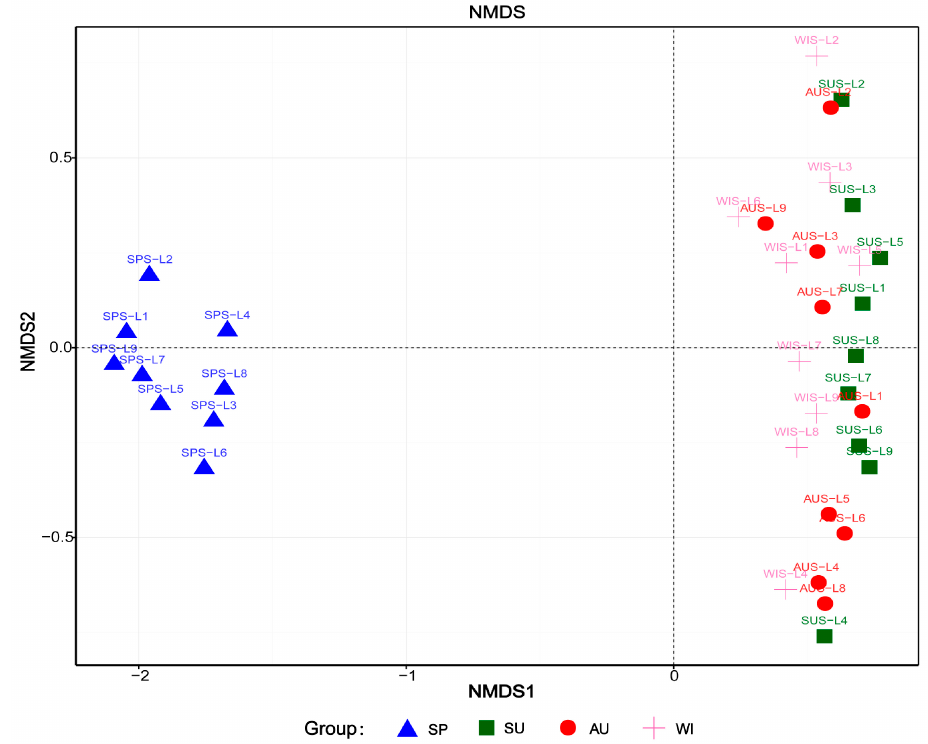
Figure 6. Representation of bacterial community structure based on Weighted UniFrac.